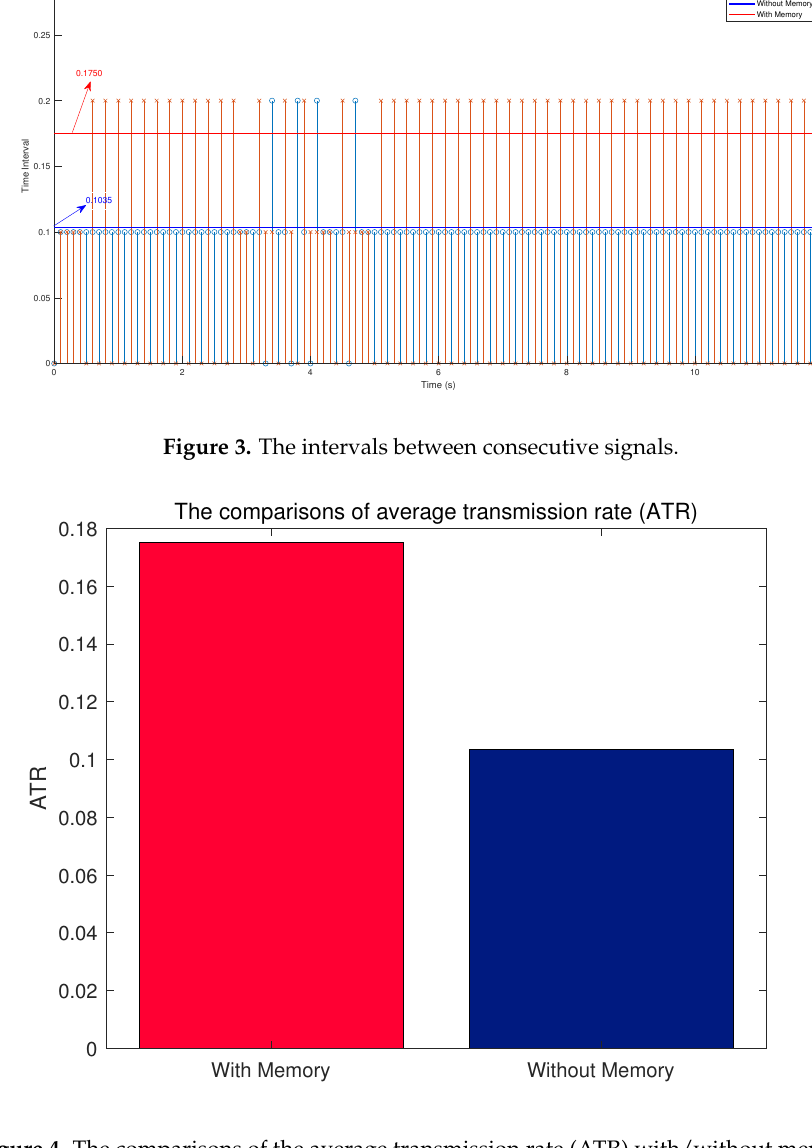
Figure 4. The comparisons of the average transmission rate (ATR) with/without